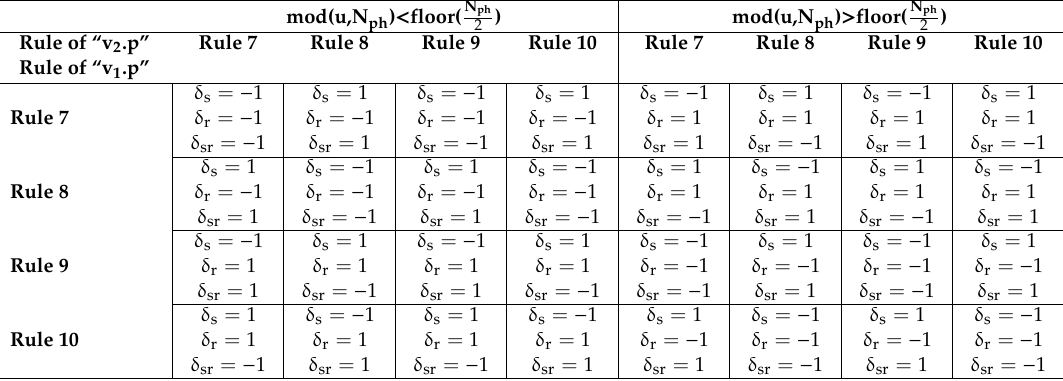
Table A1. Pulsating torque components due to interactions of harmonics of rules 7, 8, 9 and 10.